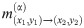
Isotropic, but chiral migration in a lattice-based model.The panels illustrate the computation of migration fluxes m(x1,y1)→(x2,y2)(α) given by Eq (9) for different orientations of the migration direction relative to the lattice. Note that the choice of the migration coefficients is always made relative to the direction of migration and not relative to the coordinate system.